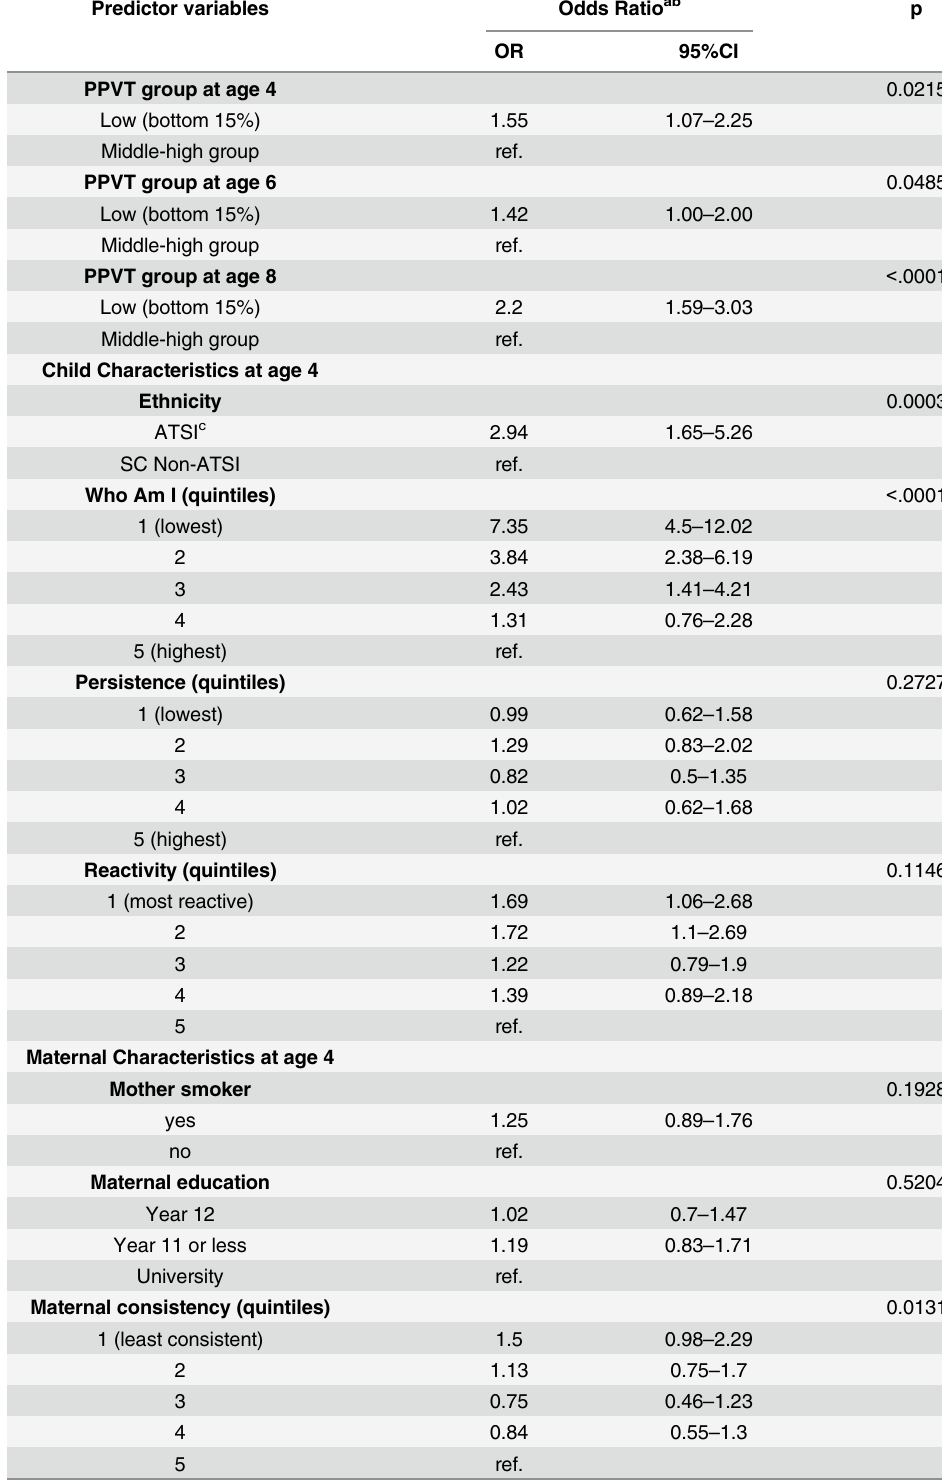
Table 5. Multivariate associations between child, maternal and family characteristics and low literacy at 10